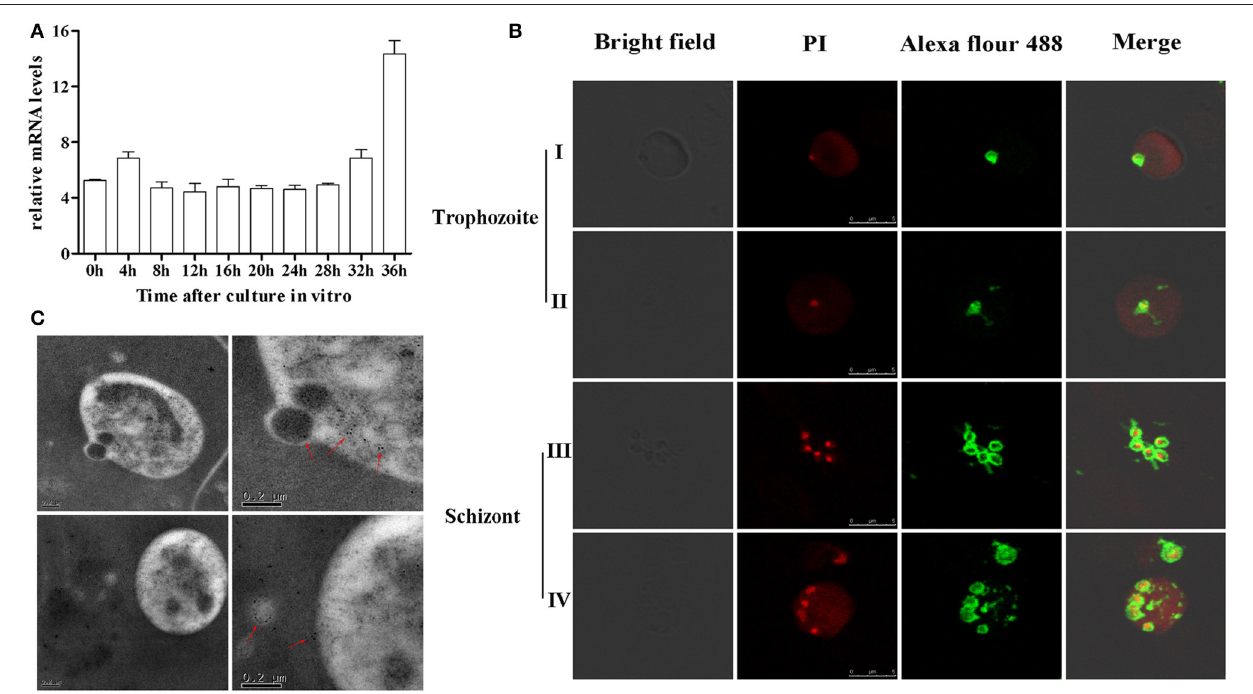
FIGURE 2 | Expression and localization of BMSA in Babesia microti . (A) Transcriptional analysis of bmsa using quantitative PCR indicated that transcription of BMSA began early after parasite invasion and increased from 32h to 36h (schizonts) after synchronous culture. Results are presented as the mean ± SD of three independent experiments. (B) Immunofluorescence and laser confocal scanning microscopy indicated that BMSA was expressed during different phases. BMSA localized to the membrane of merozoites and to the cytoplasm of infected erythrocytes. Erythrocytes emit red fluorescence. (C) Immunoelectron microscopy images of BMSA showing that gold particles were located on the membrane of B. microti merozoites and in the cytoplasm of infected